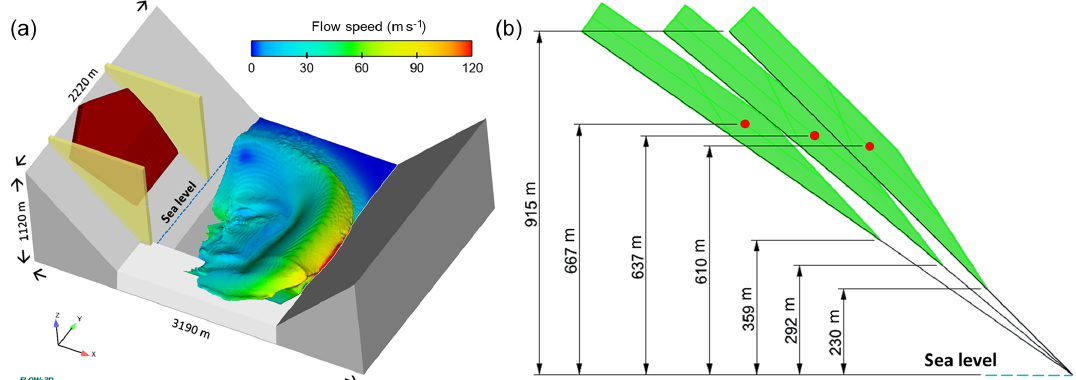
Figure 4. (a) Configuration of the bay head at Gilbert Inlet used for concept model analysis (for a slope angle of 45 ◦ ). The initial position of the impacting fluid (brown), the glacier (white), and the two constraining walls are shown. The wave propagation and flow speed contours (magnitude of the velocity considering all the vector components) before impacting the opposite slope are illustrated (simulation time = 32s). (b) Illustration showing the position of the impacting fluid and its related centre of gravity (red spot) for different slope angles (35 ◦ , − 40 ◦ , − 45 ◦